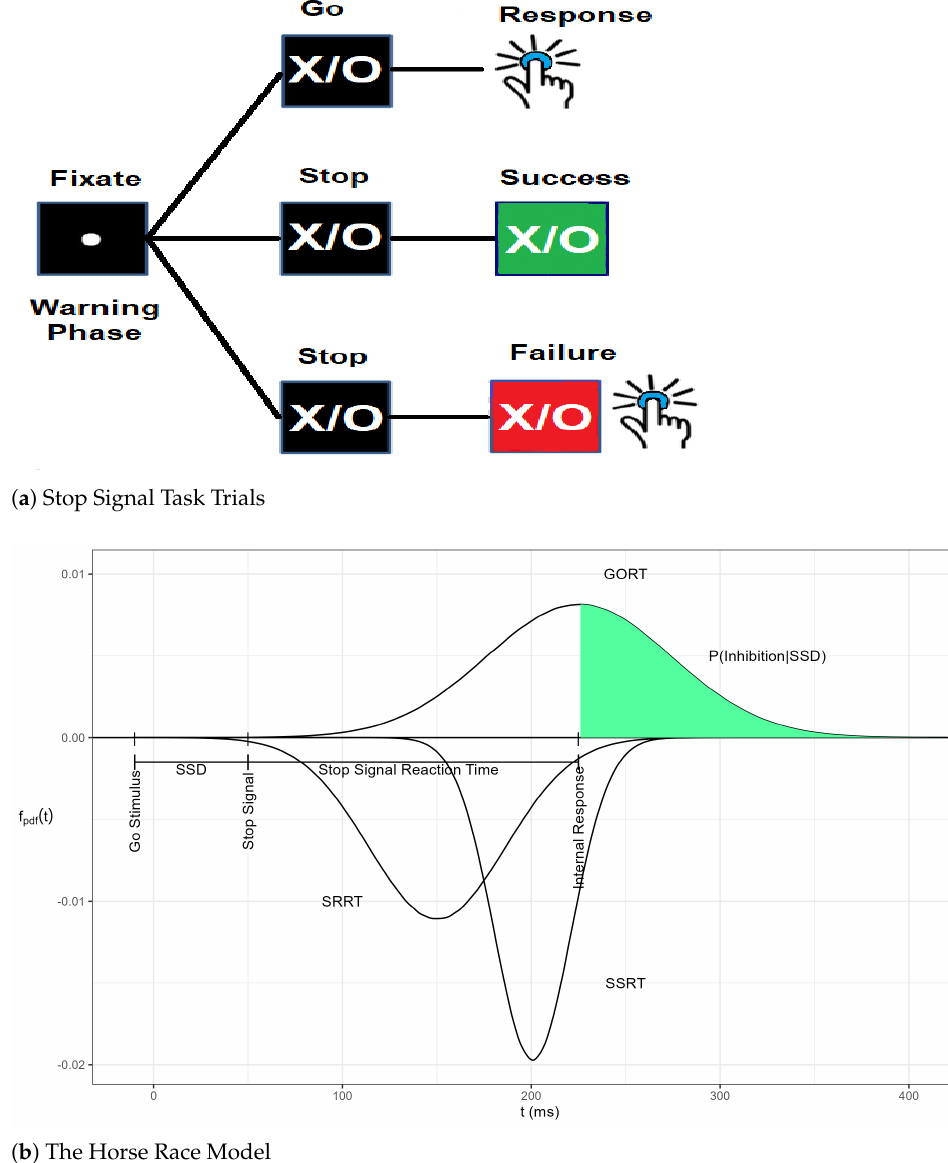
Figure 1. ( a ) The standard stop signal task; ( b ) Graphical representation of the complete horse race model: GORT: go reaction times, SRRT: signal respond reaction times, SSRT: stop signal reaction times, SSD : stop signal